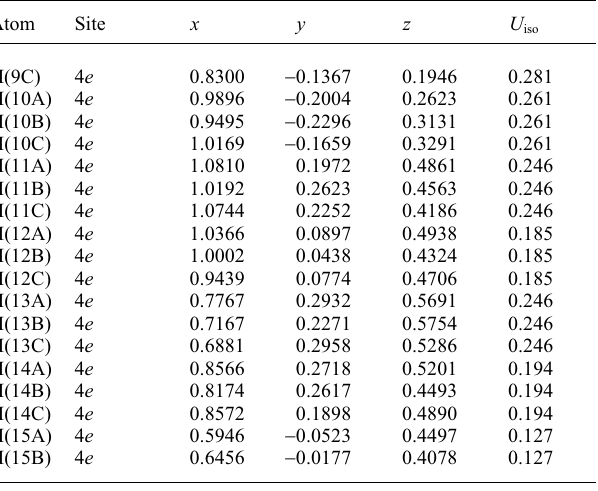
Table 3. Atomic coordinates and displacement parameters (in Å 2 )